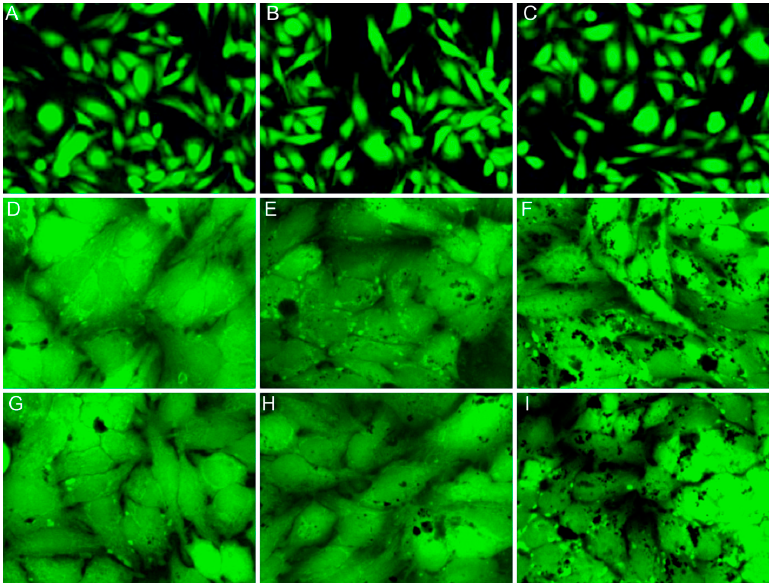
Figure 15. Effect of lead ions on HeLa cells morphology: control cells ( A ); HeLa cells with the: CD-HAp_1 ( B ); and CD-HAp_2 ( C ) nanocomposite; HeLa cells with the CD-HAp_1 nanocomposite after the adsorption of: 20 mg/L ( D ); 60 mg/L ( E ); and 120 mg/L ( F ) lead ions; and HeLa cells with the CD-HAp_2 nanocomposite after the adsorption: of 20 mg/L ( G ); 60 mg/L ( H ); and 120 mg/L ( I ) lead ions. (×200).